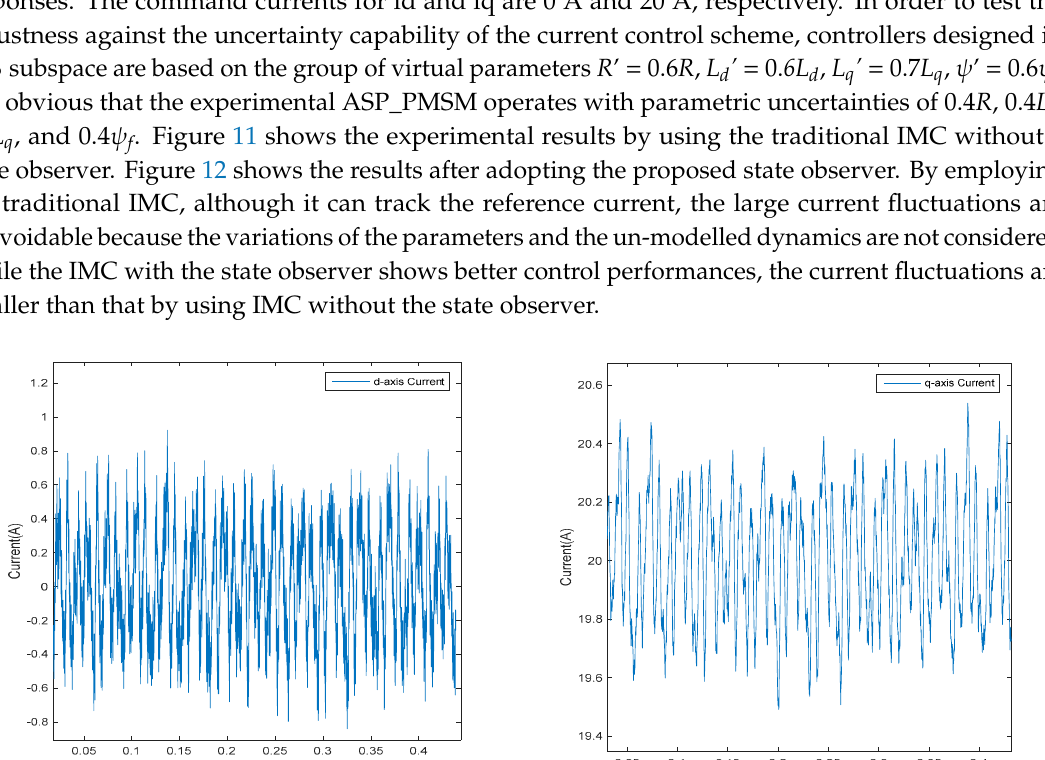
( b ) Figure 12. Experimental results after adopting the state observer, ( a ) d -axis current and ( b ) q -axis current. 6.2. Verification of Current Control Method in x-y Subspace To demonstrate the effectiveness of the proposed control algorithm in x-y subspace to eliminate the current harmonic components, experiments with and without ADALINE algorithm were conducted. The learning rate η was chosen as 10. Figure 13 shows the experimental results of phase